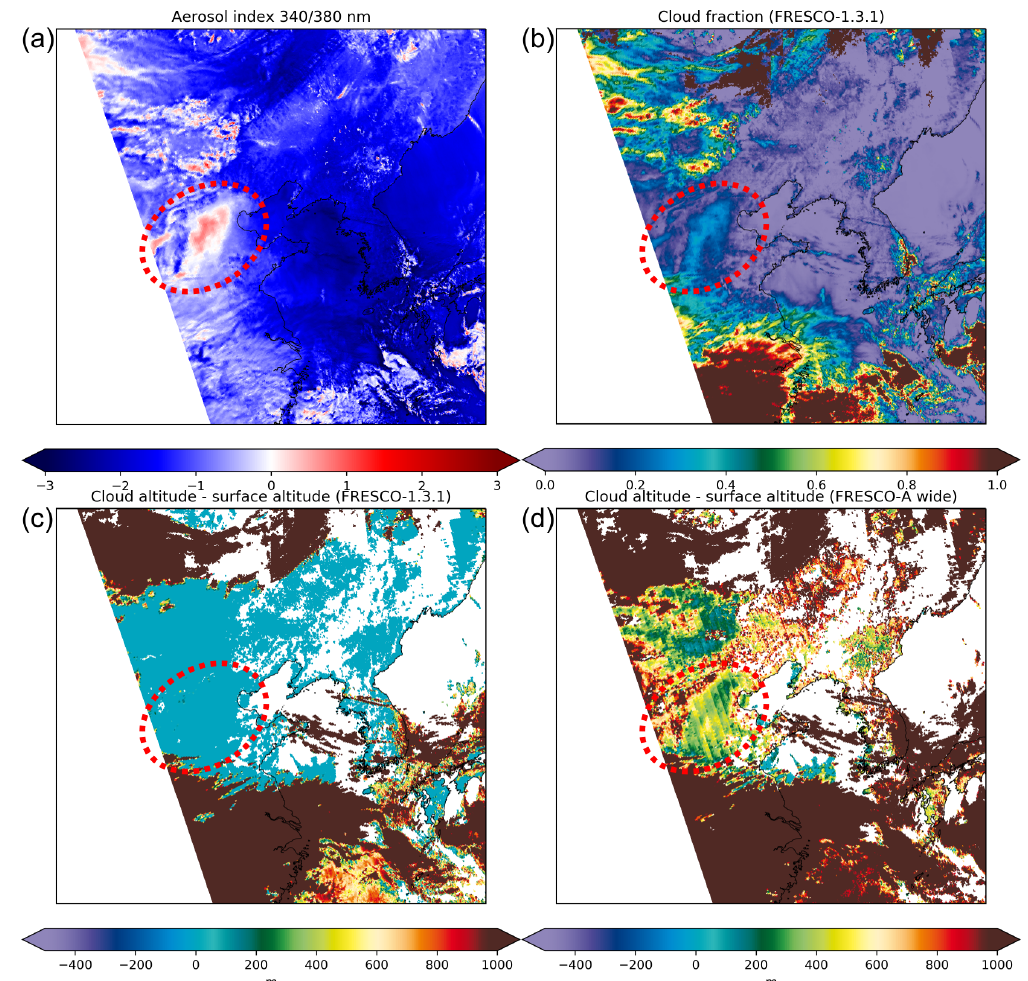
Figure 14. S5P Aerosol Index OFFL 1.2.2 (a) , S5P FRESCO OFFL 1.3.1 cloud fraction (b) , S5P FRESCO OFFL 1.3.1 cloud height offset from the surface (c) , and S5P FRESCO-A wide (version 1.4) cloud height offset from the surface (d) . Orbit 7062 at 23 February 2019, 1200 × 1200km 2 square centered at 38 ◦ N, 120 ◦ E. The cloud height products are filtered using qa_value > 0 . 5 and CF > 0 . 05. The region of interest is indicated by the red-dashed